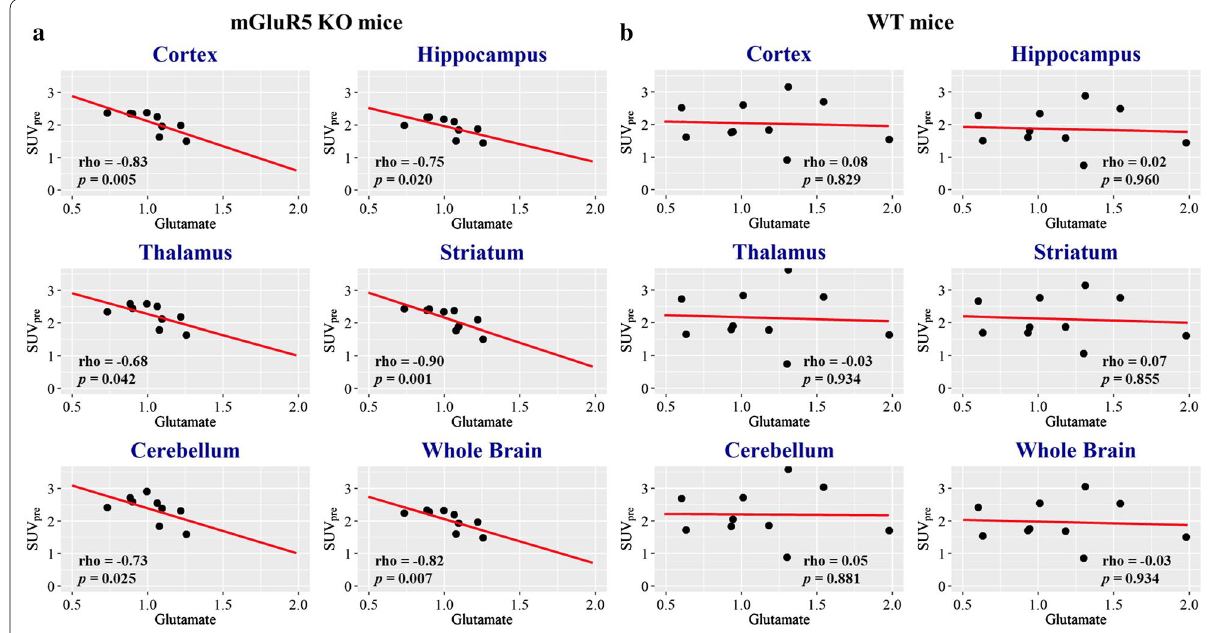
Fig. 2 Correlation analysis results between prefrontal glutamate levels to MRS and the baseline [ 18 F]FDG PET results (SUV pre ) in ROIs. There were significant negative correlations in mGluR5 KO mice ( p < 0.05) ( a ), while no significant correlations were observed in WT mice ( b ). Fisher’s Z‑transformation showed significant between‑group differences of correlation coefficients in the cortex ( z p 0.006), and whole brain ( z 2.01 p 0.045). SUV, standardized uptake value; ROI, region of = = − =